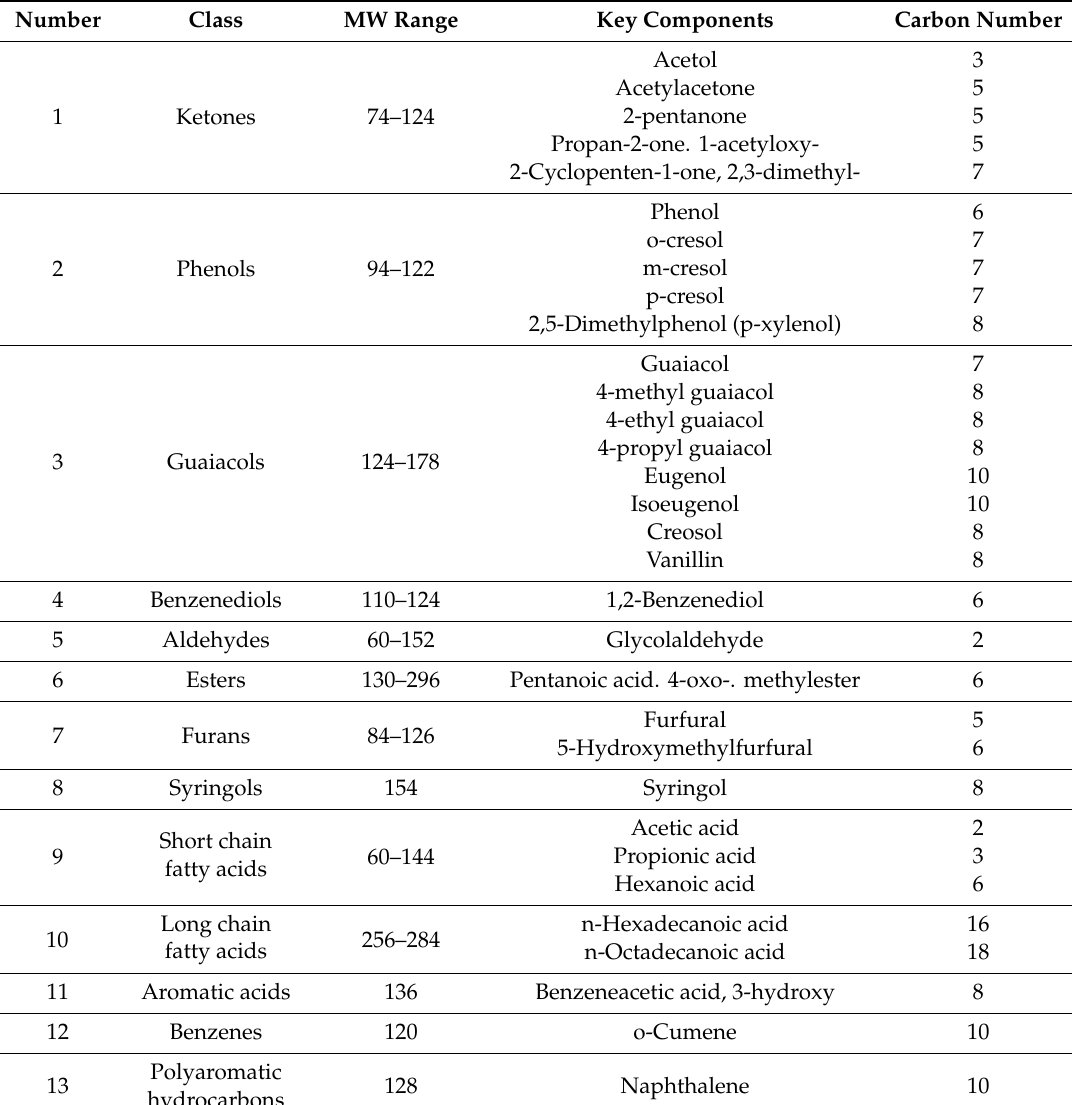
Table 8. Typical chemical classes and key components observed in sCO 2 extracts